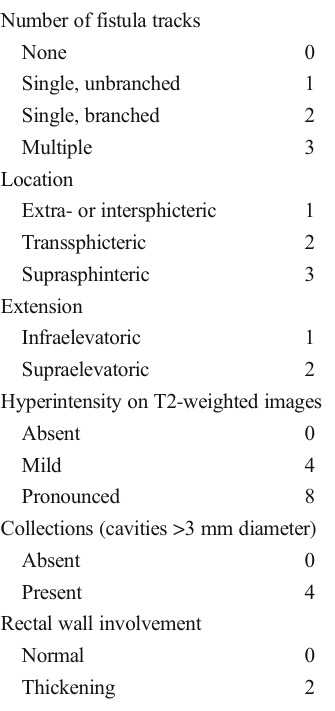
Number of fistula tracks